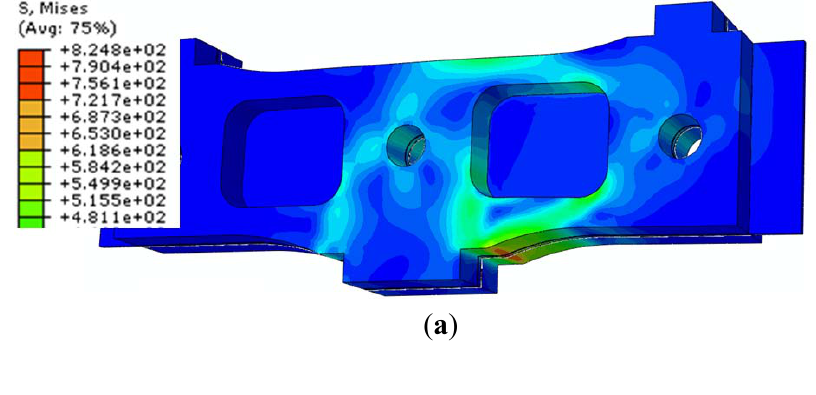
Figure 6. The state of von Mises stresses for asymmetric loading case ( σ ( a ) Sensor module; ( b ) Central elastic